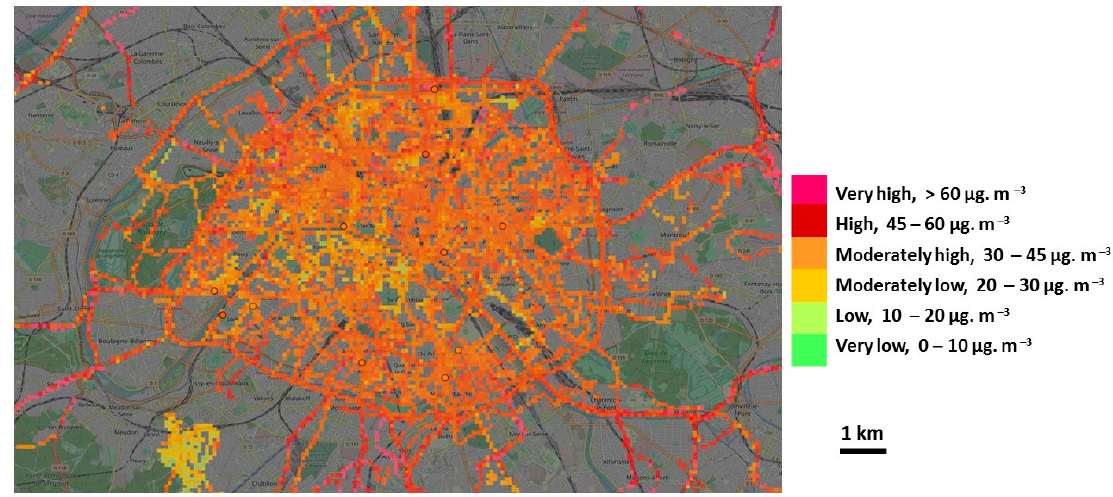
Figure 16. Pollution map in Paris averaged for the 25–27 November 2020. North is up.